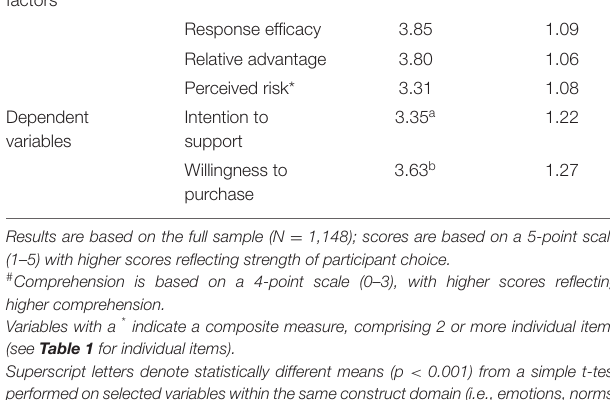
Frontiers in Sustainable Food Systems |